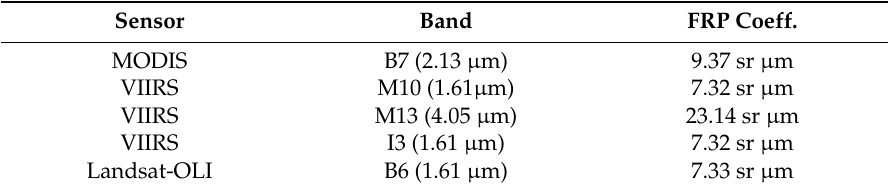
Table 1. The sensor specific FRP Coefficients used throughout the